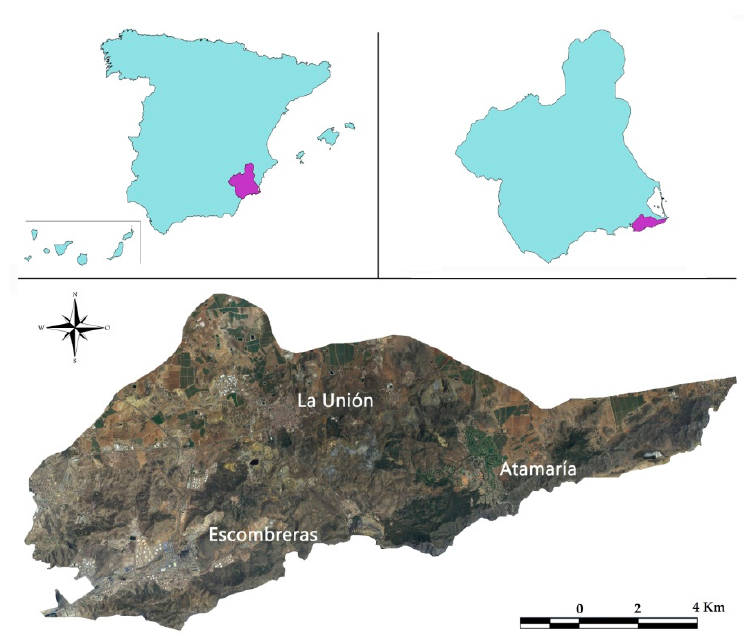
Figure 1. Location of the Cartagena-La Unión mining area. Source: own statistics.